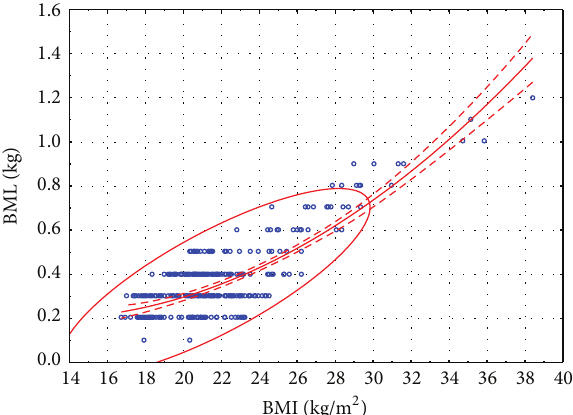
Figure 1: Sauna-induced BML in women from different BMI groups.